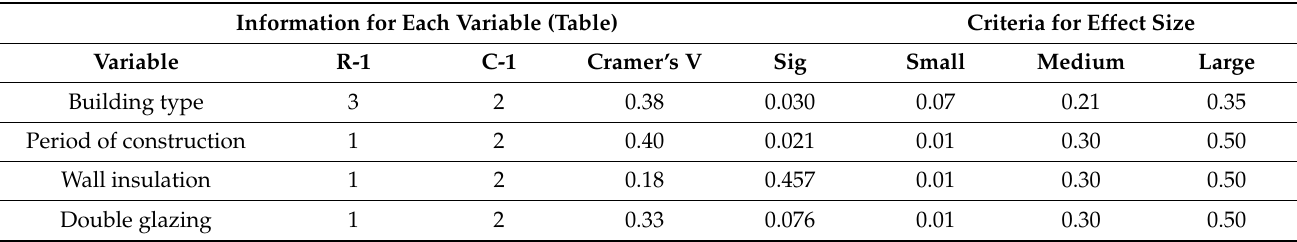
Table 5. Cramer’s V test results of building variables between clusters in summer. Information for Each Variable (Table)